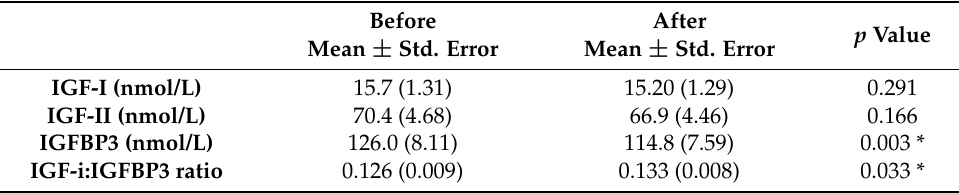
Table 3. Change from baseline in plasma concentrations of growth factors. Before Mean ± Std. Error